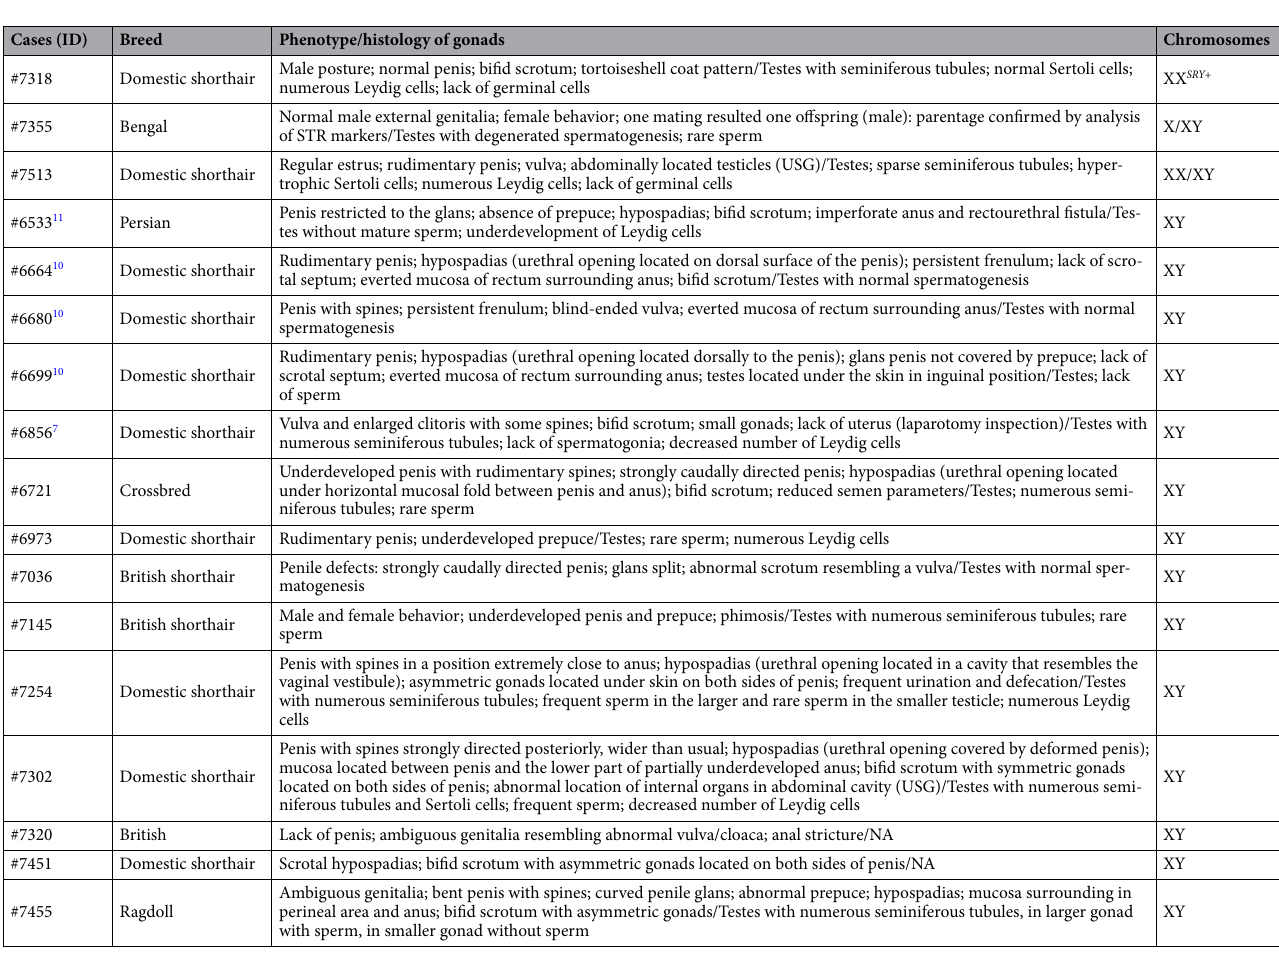
Table 1. Characteristics of the DSD cats. NA not